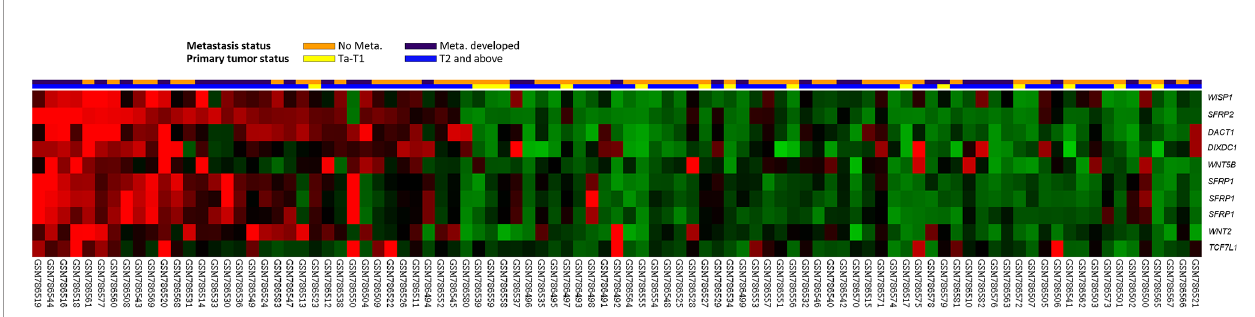
FIGURE 1 | Expression pro fi les of the top 8 genes correlated with the Wnt signaling pathway in advanced/metastatic bladder tumors. The expression levels of upregulated and downregulated genes are marked in red and green, respectively. A comparative analysis (invasive vs. noninvasive and metastatic vs. nonmetastatic) was conducted under supervision. We identi fi ed SFRP2 as the most considerably upregulated gene related to the Wnt signaling pathway (GO: 0016055) among bladder cancer patients with